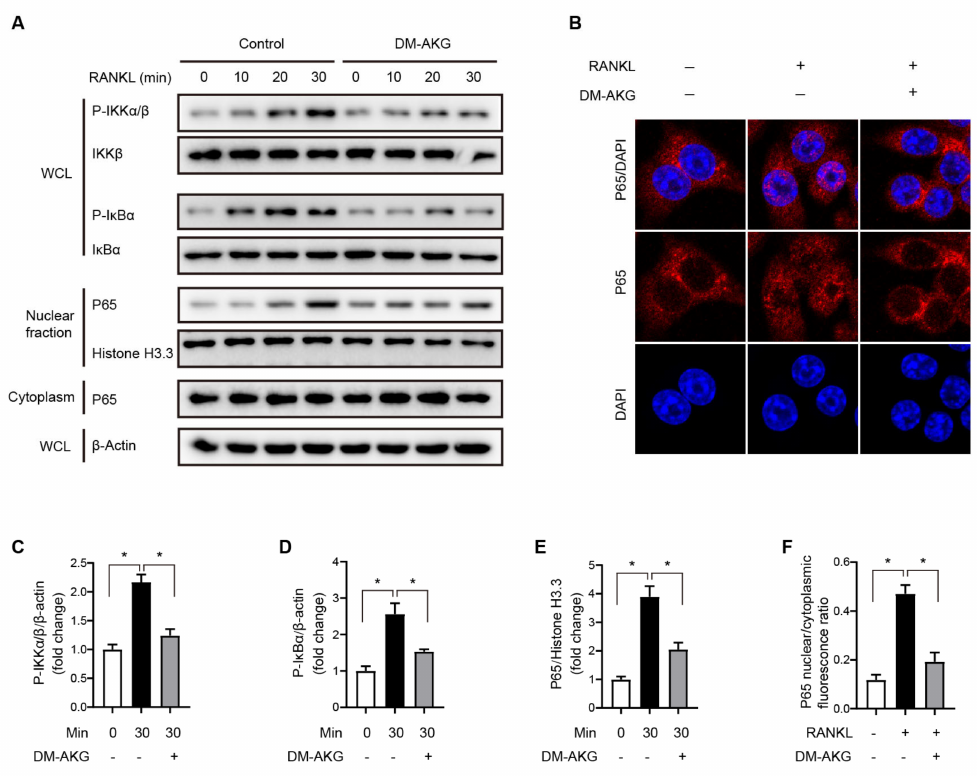
Figure 3. DM-AKG inhibits RANKL-induced NF- κ B activation in RAW264.7 cells. ( A ) Immunoblot analysis of nuclear and cytoplasm P65, phosphorylated (P-) IKK α / β , IKK β , phosphorylated (P-) I κ B α , and I κ B α in RAW264.7 cells incubated with or without 5 mM DM-AKG for 3 h and then stimulated with RANKL. ( n = 3). WCL, whole-cell lysate. ( B ) Representative images of immunofluorescence for P65 incubated with or without 5 mM DM-AKG for 3 h and then stimulated with or without RANKL for 30 min. Quantification of immunoblot of ( C ) nuclear P65, ( D ) P-IKK α / β , and ( E ) P-I κ B α incubated with or without 5 mM DM-AKG for 3 h and then stimulated with RANKL for 30 min ( n = 3). ( F ) Quantitative immunofluorescence results of P65 nuclear translation ( n = 3). All data were presented as means ± SEM. *, p <